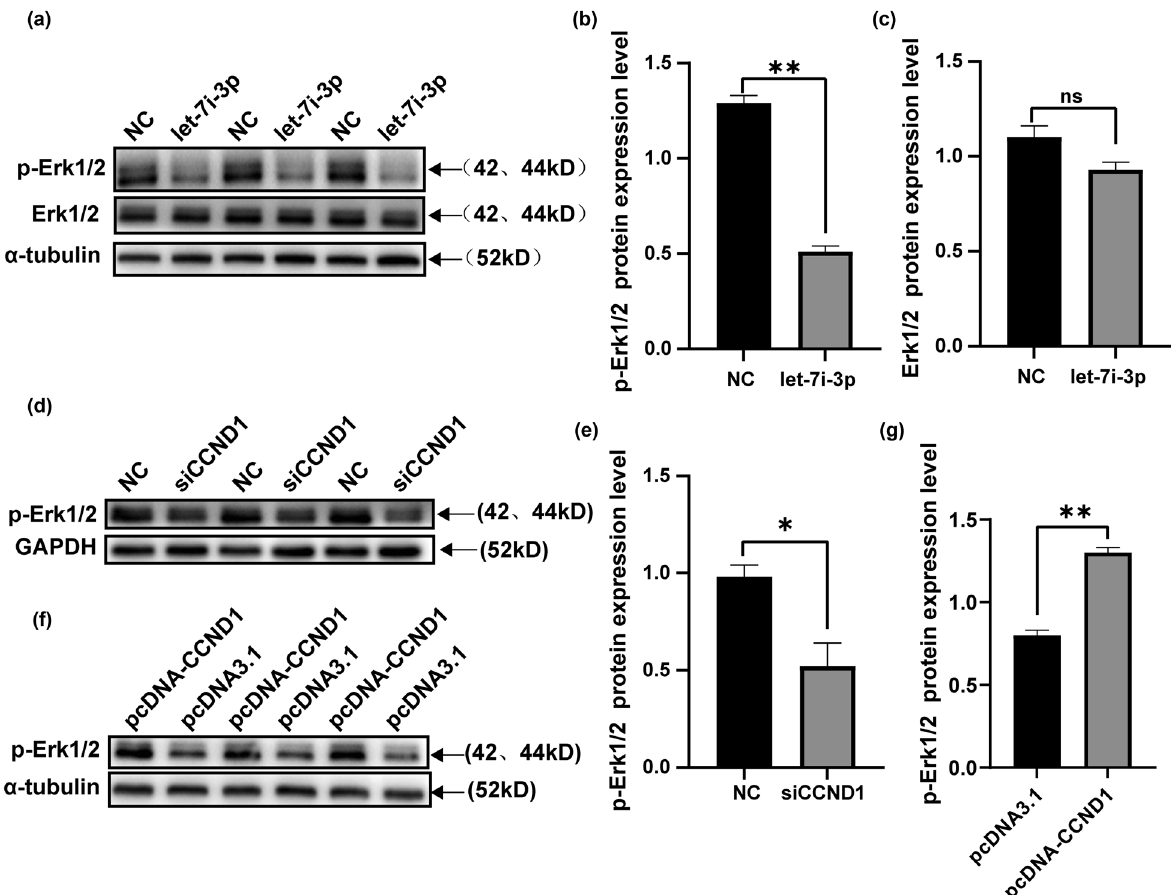
Figure 6: E ff ects of let - 7i - 3p and CCND1 on the ERK signaling pathway. ( a ) Western bolts of Erk1/2 and p - Erk1/2 after the transfection of let - 7i - 3p mimics or NC in HCT116 cells and statistical histogram was shown at right ( b and c ) . ( d ) Western bolts of p - Erk1/2 after transfection of siCCND1 or NC in HCT116 cells and statistical histogram was shown at right ( e ) . ( f ) Western bolts of p - Erk1/2 after transfection of pcDNA - CCND1 or pcDNA3.1 in HCT116 cells and statistical histogram was shown at right ( g ) . * P < 0.05 and ** P <